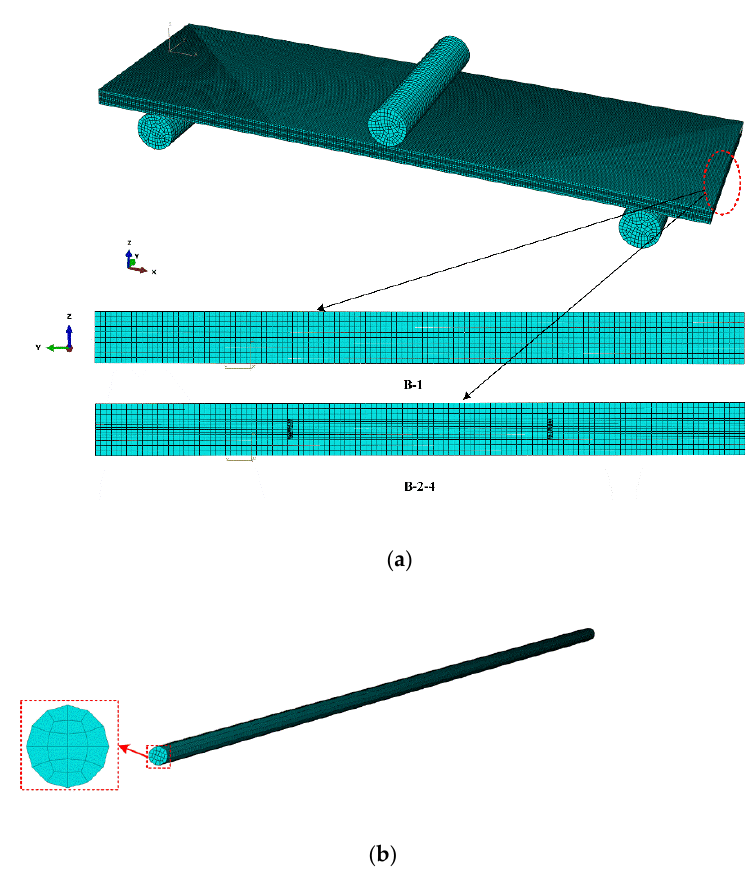
Figure 5. Finite element model of composite laminates. ( a ) The meshing of composite laminates, and ( b ) the meshing of SMA.